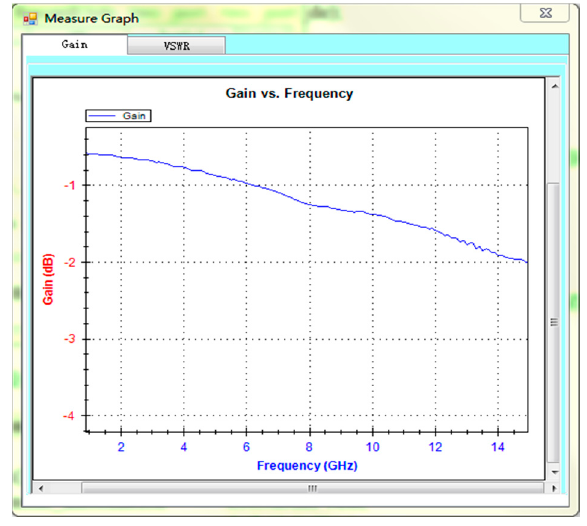
Figure 14. The result interface of the automatic test system.